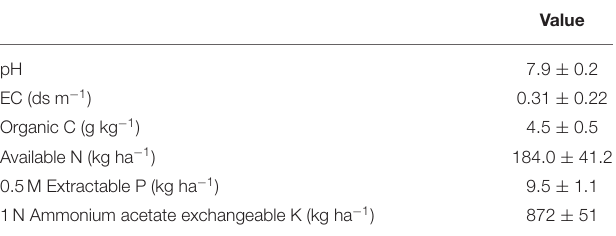
TABLE 1 | Soil physicochemical properties (averaged across